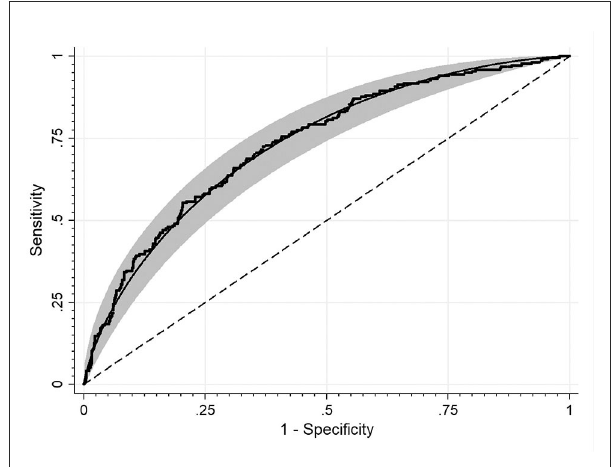
FIGURE1 ROC curve for detecting HOMA-IR cut-off values discriminating the insulin resistance based on the SHBG level. The area under the curve: 0.73.